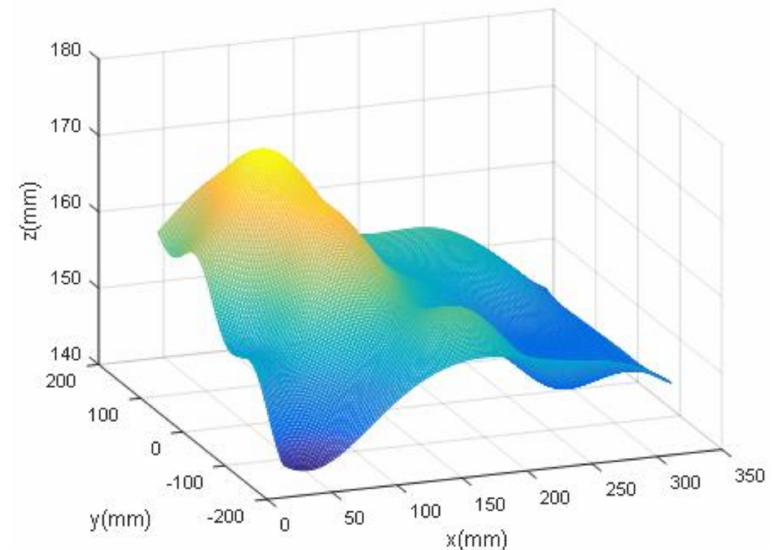
Figure 10. Simulated sea surface waves ( U = 1.0 m/s, t = 10 s